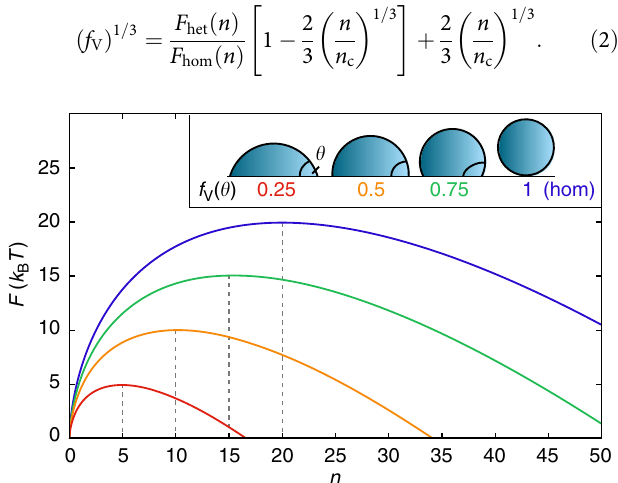
Fig. 1 The traditional view of free energy pro fi les in hetCNT. Free energy pro fi les are shown for a crystalline cluster containing n molecules for different contact angles. The inset shows the de fi nition of the contact angle and representative droplets corresponding to different values of f V ( θ )